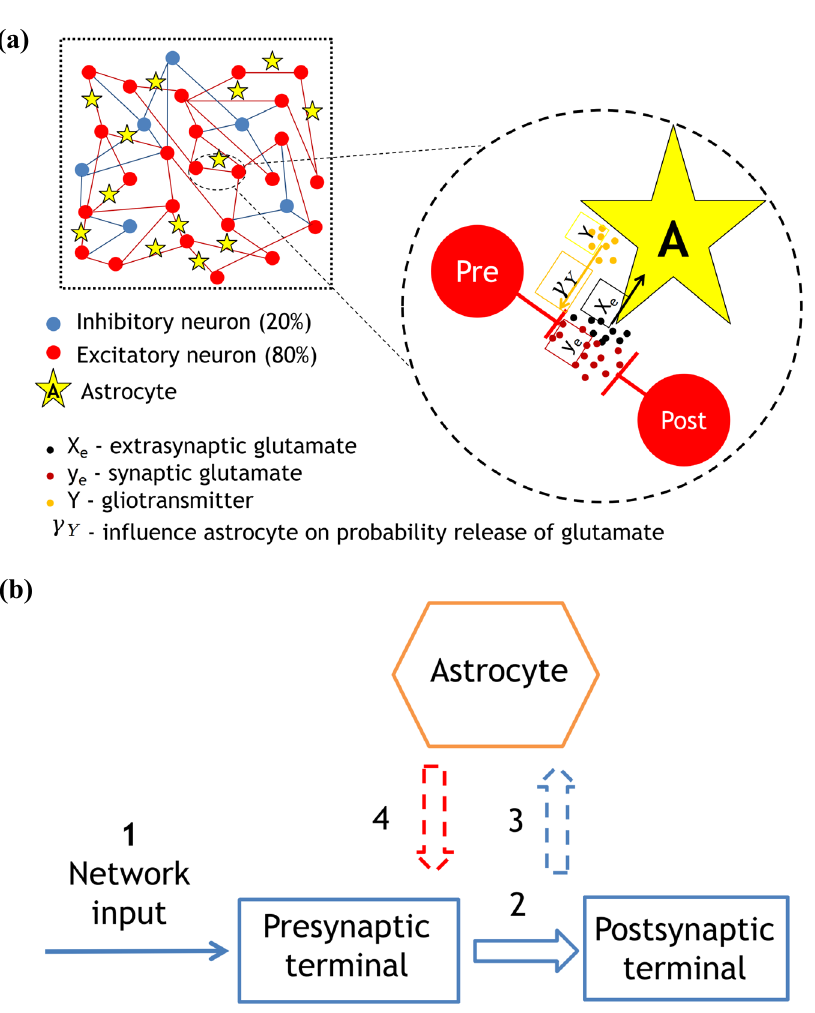
Figure 1. ( a ) - Schematic view of the network and a schematic representation of astrocytic modulation of synaptic current, ( b ) - Diagram of the sequence of influences and interactions in a tripartite synapse: 1 - input from the neural network to the presynaptic terminal, 2 - release of the neurotransmitter, 3 - diffusion of the neurotransmitter and binding to receptors on the astrocyte membrane, 4 - release of the gliotransmitter from the astrocyte and its effect on the presynaptic terminal through a change in the probability of neurotransmitter